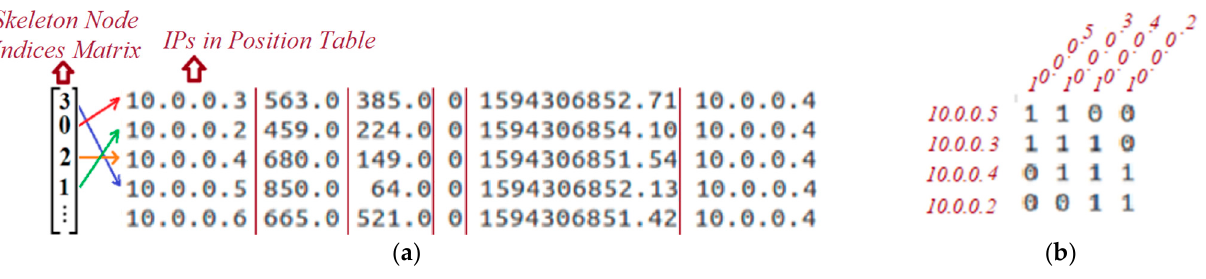
Figure 6. Skeleton information matrices: ( a ) skeleton node indices matrix (SNIM); ( b ) skeleton connection representation matrix (SCRM).